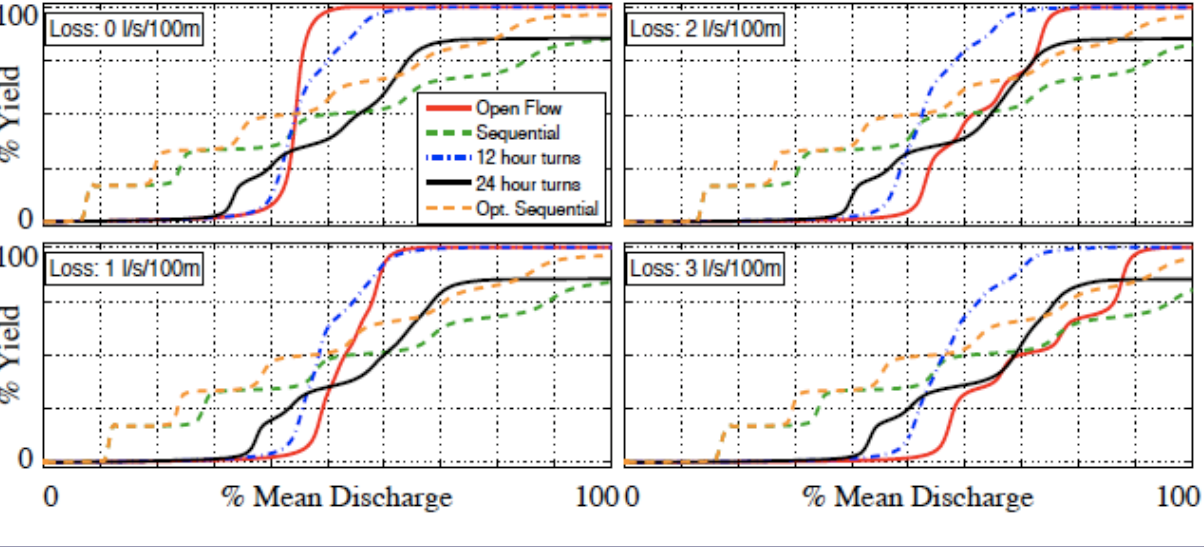
Fig. 10 . The impact of canal losses on the performance of water allocation policies versus changes in mean river discharge